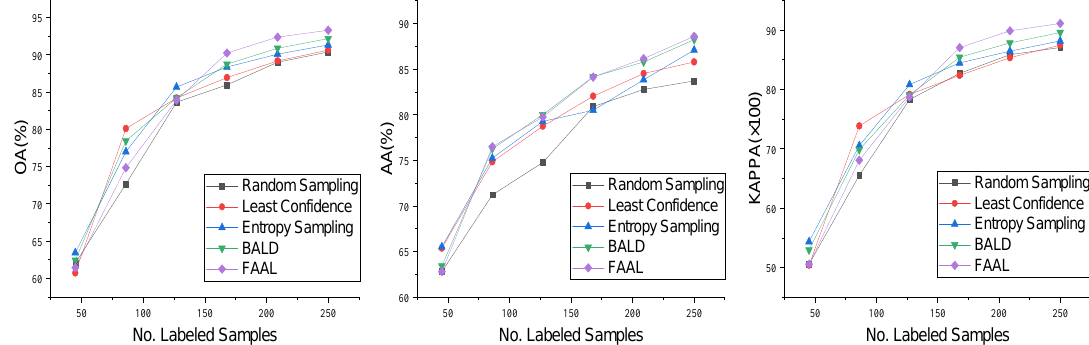
Figure 7. Performance after each active learning loop on Pavia University. The number of initial labeled samples is 45. There are 86, 127, 168, 209, and 250 labeled samples after the first, the second, the third, the fourth, and the fifth active learning loop, respectively. Three general metrics: OA (leftmost), AA (middle), and KAPPA (rightmost) are used for